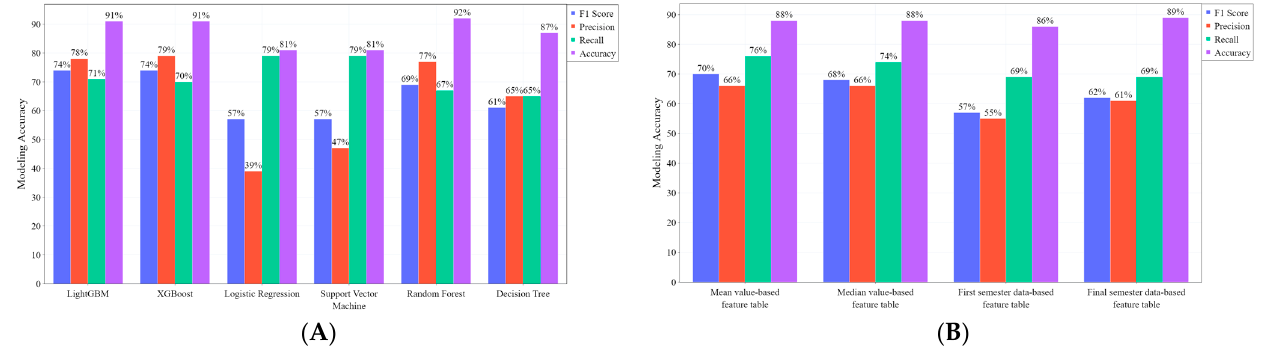
Figure 3. ( A ) Average performance of the six models. ( B ) Average performance of the four feature tables.